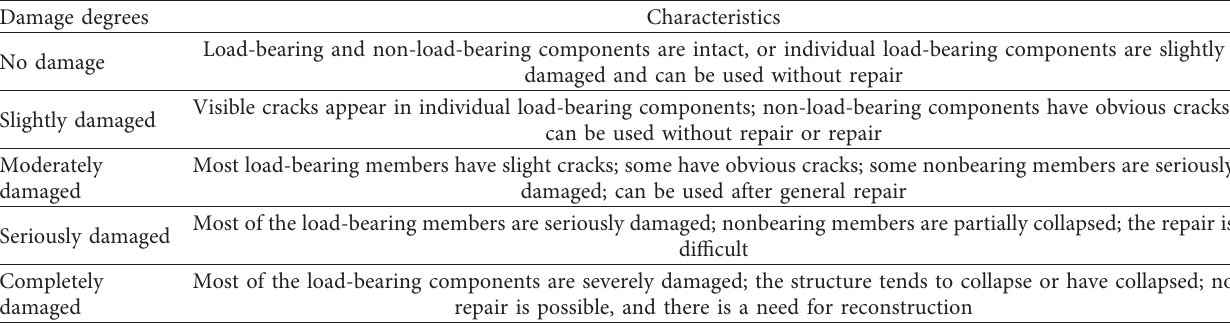
Table 3: The characteristics of five damage